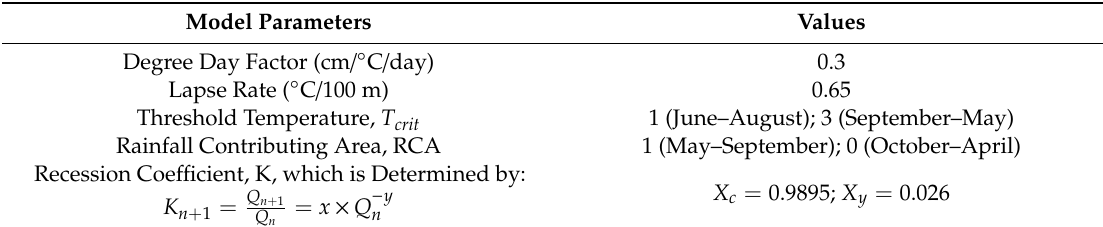
Table 3. Parameters determined by hydrological judgment as described in the